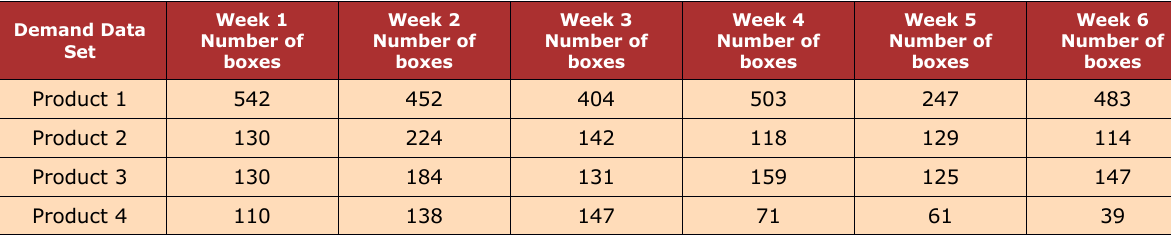
Table 3. Case-2 demand